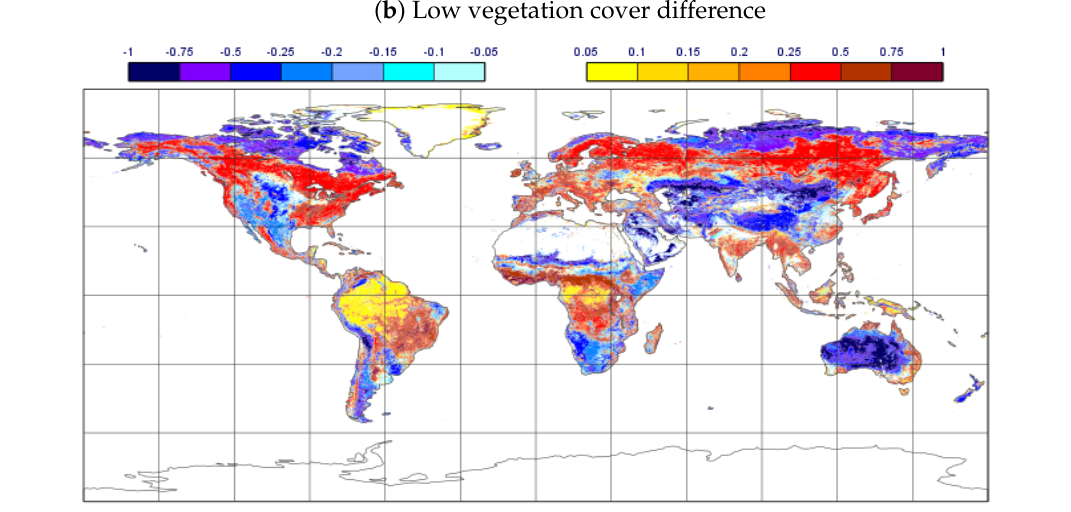
Figure 2. Vegetation cover difference: ESA-CCI - GLCCv1.2 based maps: ( a ) for the high vegetation types (forest and trees); ( b ) for the low vegetation types (crops, grass and herbaceous